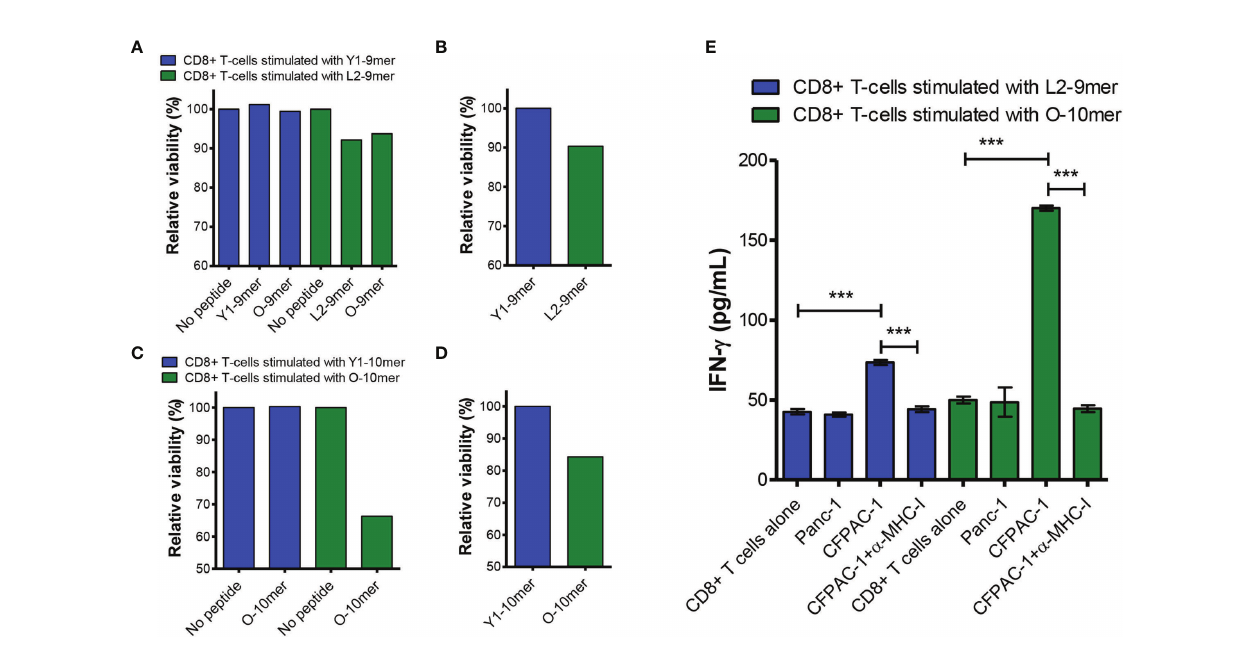
FIGURE 4 | CD8+ T cells stimulated with L2-9-mer and O-10-mer G12V peptides recognize peptide presented by G12V-positive pancreatic cancer cells. CD8+ T cells isolated from an HLA-A*02:01-positive healthy donor blood were stimulated four times with autologous mature dendritic cells pulsed with Y1-9-mer or L2-9-mer peptides. Seven days after the last round of stimulation, CD8+ T cells were challenged with T2 cells pulsed with the same RAS mutants (anchor-modi fi ed or original), original or left without peptide (A) or with CFPAC-1 cells (B) and viability determined by staining the target cells with EthD-1 and measured by FACS. (C, D) CD8+ T-cells from another HLA-A*02:01-positive donor were stimulated with peptides Y1-10-mer or O-10-mer as in (A, B) and challenged with T2 cells pulsed with the same RAS peptides or left without peptide (C) or with CFPAC-1 cells (D) . (E) CD8+ T cells stimulated as in (A – D) with L2-9-mer or O-10-mer peptide were incubated overnight with G12V-negative/ HLA-A*02:01-positive Panc-1 or G12V-positive/HLA-A*02:01-positive CFPAC-1 cells with or without blocking anti-MHC-I antibodies. Supernatants were collected and assayed for IFN- g by ELISA. Data shown in (E) are from three independent repeats. The data were analyzed by one-way ANOVA; ***p< 0.001. Graph shows mean ±